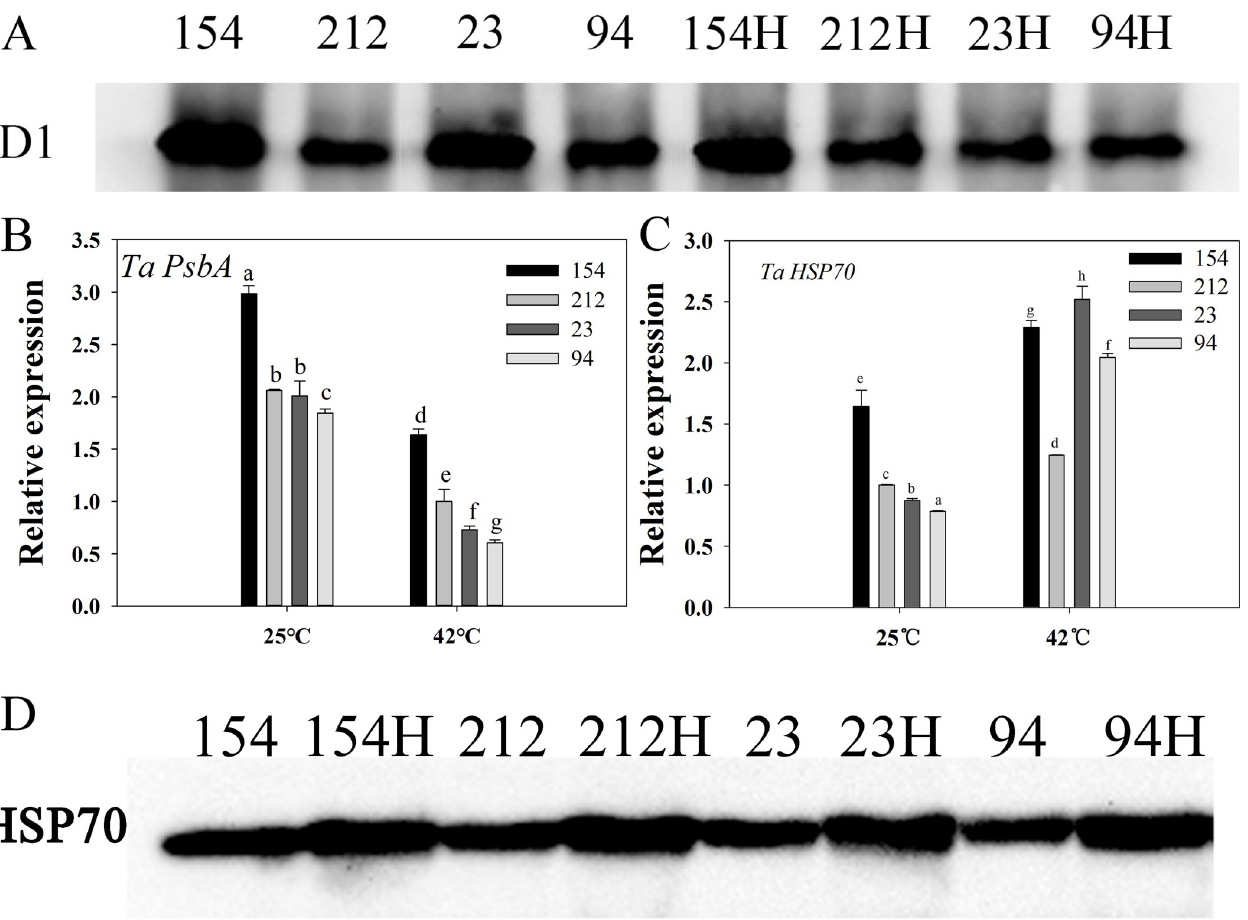
Fig 5. Accumulation and gene expression of D1 protein and heat shock protein 70 (HSP70) in NILs under high-temperature stress. (A) Western blot results of D1 protein, (B) gene expression of D1 ( PsbA ), (C) HSP70 gene expression, (D) Western blot results of HSP70. Lines 154 and 23 possess high photosynthetic rates; Lines 212 and 94 possess low photosynthetic rates. The values are the mean ± SE from three independent experiments. Different letters indicate significant differences at P = 0.05.